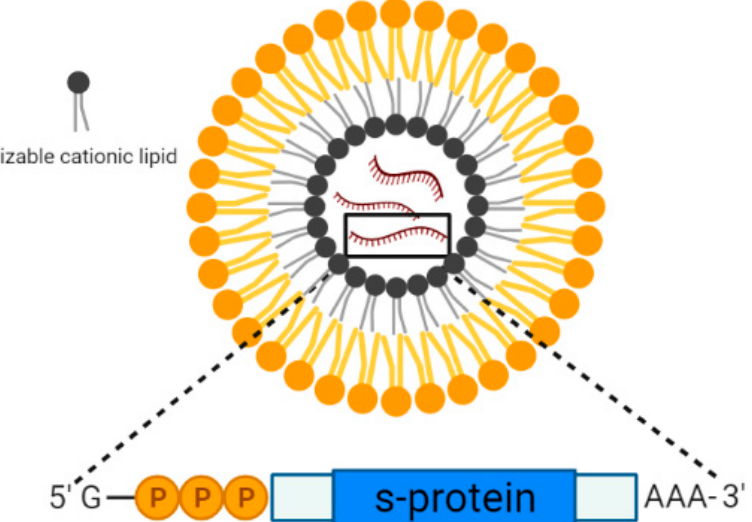
Figure 4. Schematic representation of the lipid nanoparticle consisting of ionizable cationic lipids encapsulating mRNA encoding the SARS-CoV-2 spike protein.